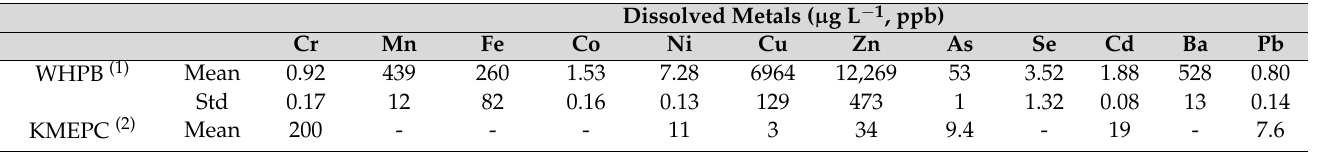
Table 4. Comparison of dissolved metal concentration in WHPB samples with marine environmental standards for metals in